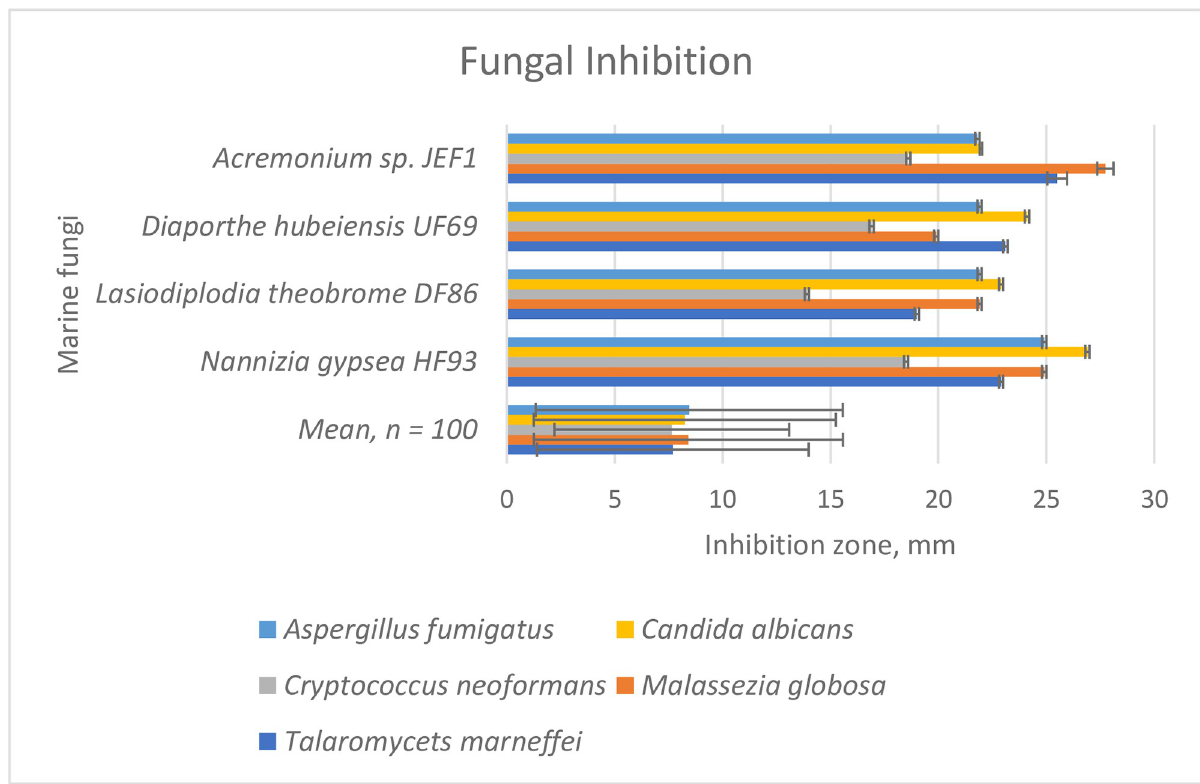
Fig 5. Inhibition (zone of inhibition, mean and error bar for SD) of five pathogenic fungi (in colors) by the metabolites of the marine fungi isolated from the coasts of the Red Sea and the Arabian Gulf. Mean refers to the mean of all isolates tested.